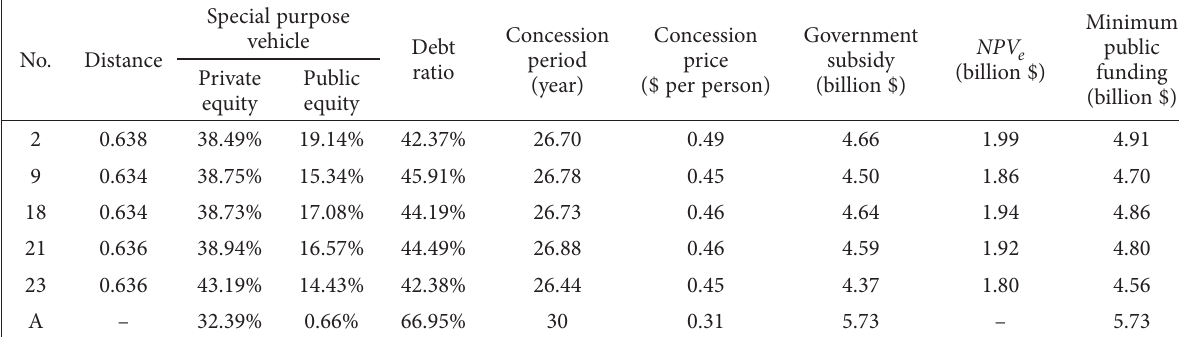
Table 7. Comparison of different alternative solutions